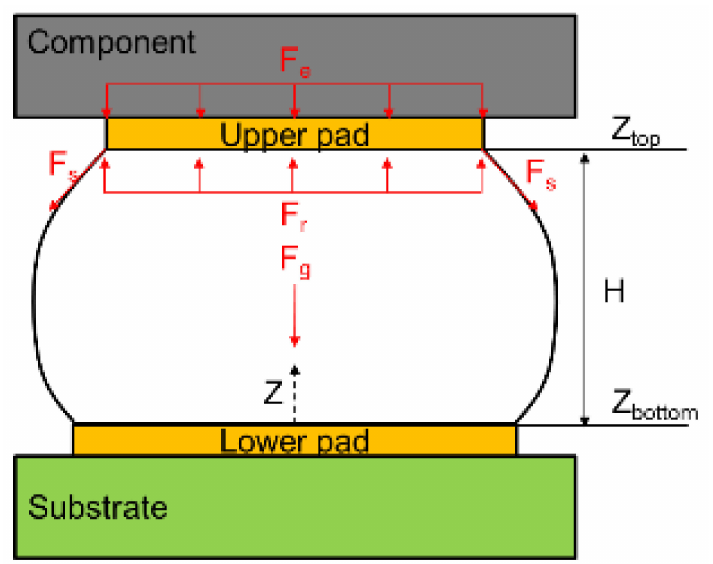
Figure 1. Geometry of the solder joints in the reflow